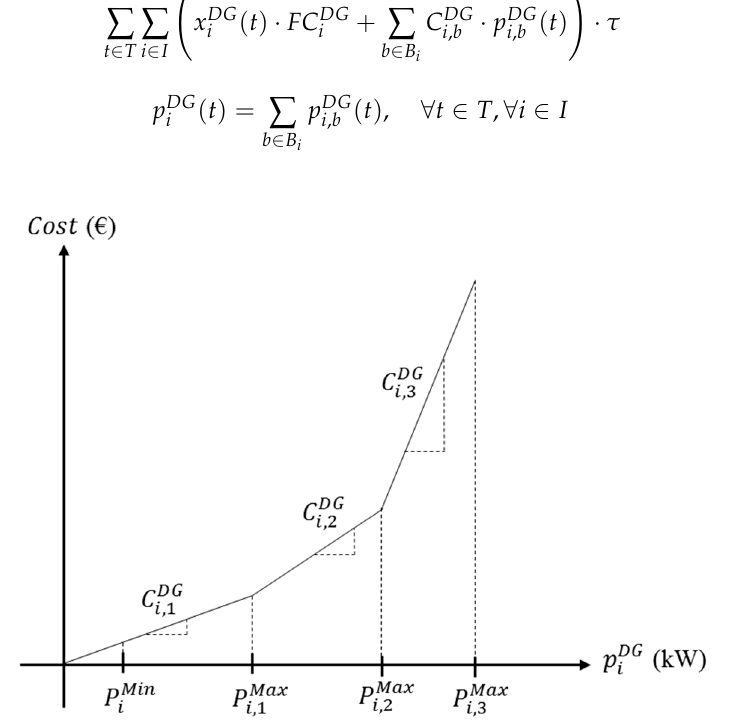
Figure 4. Linear cost function of distributed generation (DG) unit i .